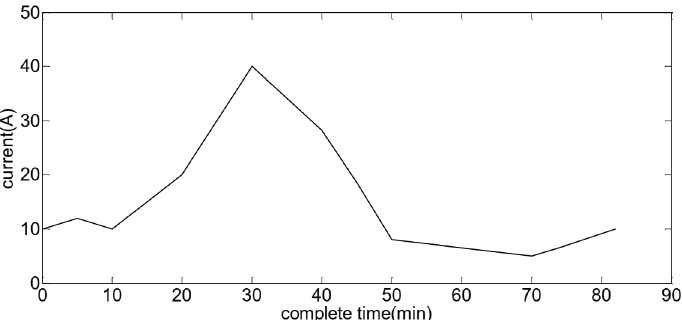
Figure 13. The variable current curve.